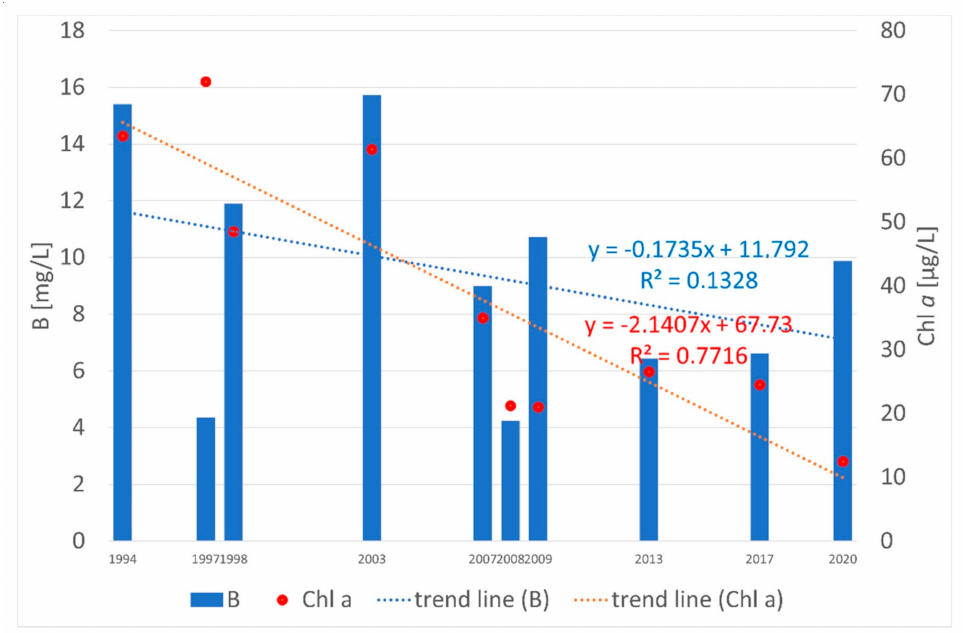
Figure 3. Changes in phytoplankton biomass, chlorophyll a concentrations, and the trend lines in the Vistula in the period from 1994 to